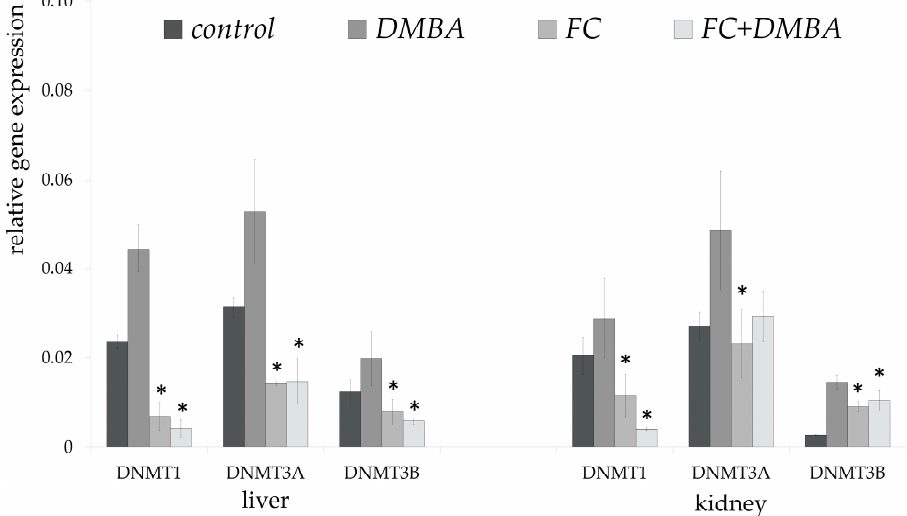
Figure 5. Relative gene expression of DNMT genes. Relative gene expression of DNA methyltrans- ferases at the mRNA level in the liver and kidney of experimental animals compared with the mRNA level of HPRT1 (DMBA: 7,12-dimethylbenz(a)anthracene, HPcFE: Fruit seed and peel extract); * significantly different from DMBA-treated mice ( p < 0.05). Error bars represent the standard deviation.